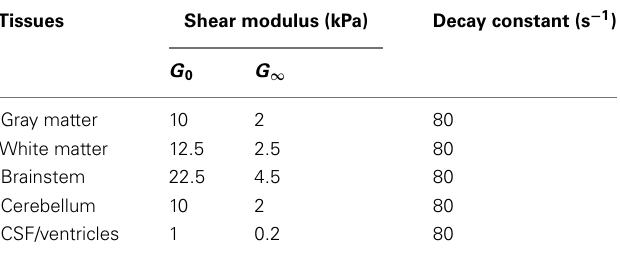
et al. (35) was used to capture the intracranial responses from blast loadings with and without ACH helmet in use ( Figure 3 ).